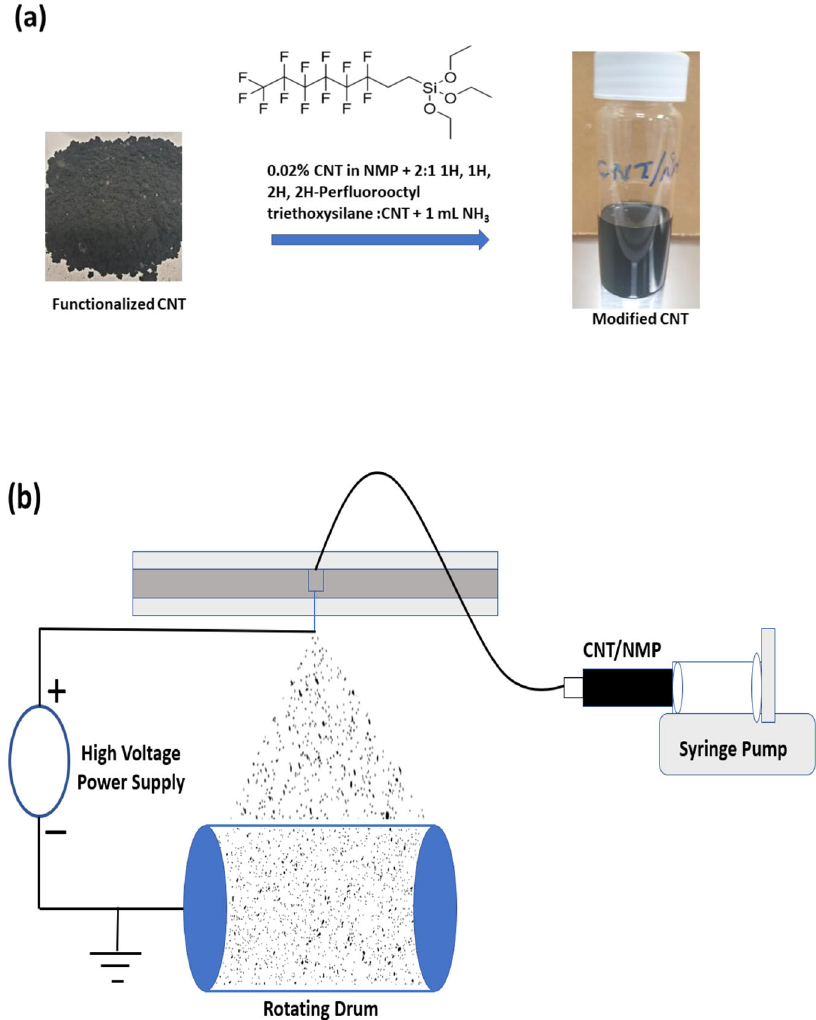
Fig. 5 Electrospraying process. a Preparation of modi fi ed CNT/NMP dispersion, and b Electrospraying of CNT/NMP